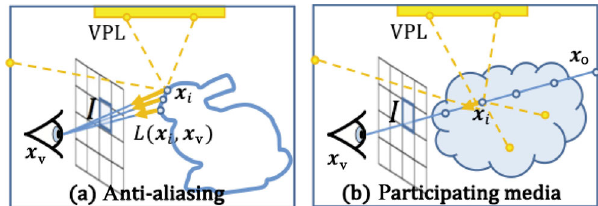
Fig. 2 Pixel value estimation using multiple shading points.